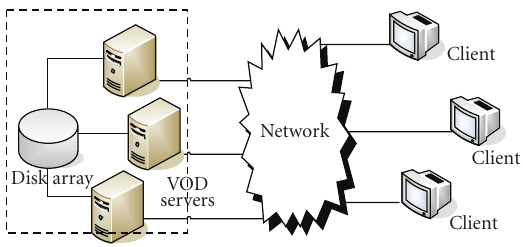
Figure 1: Architecture of the VOD